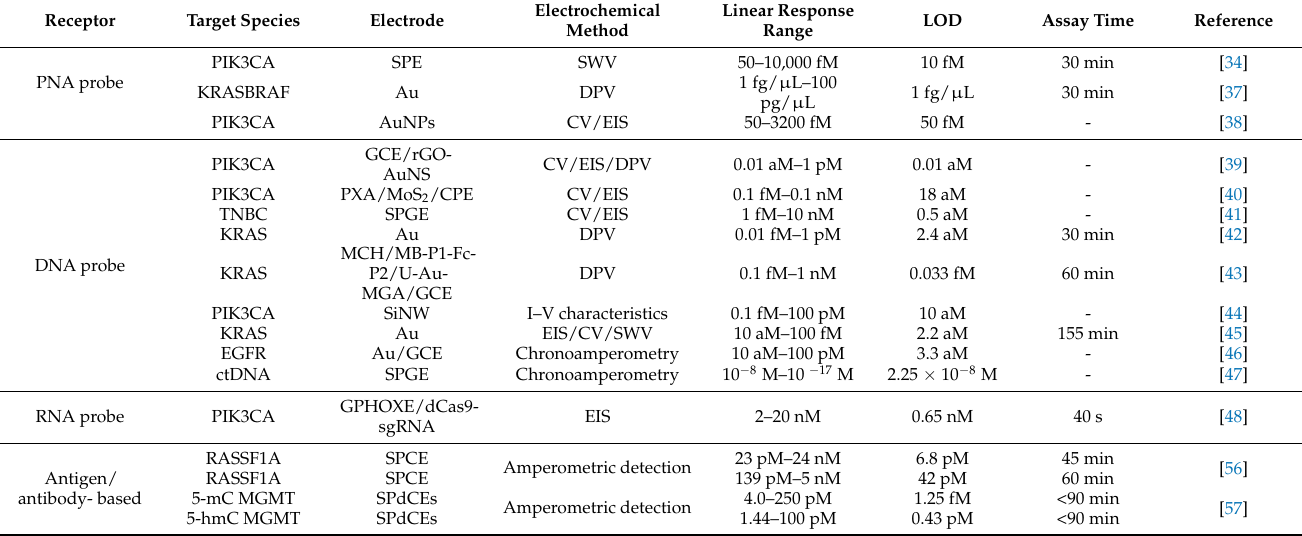
Table 2. Comparison of different